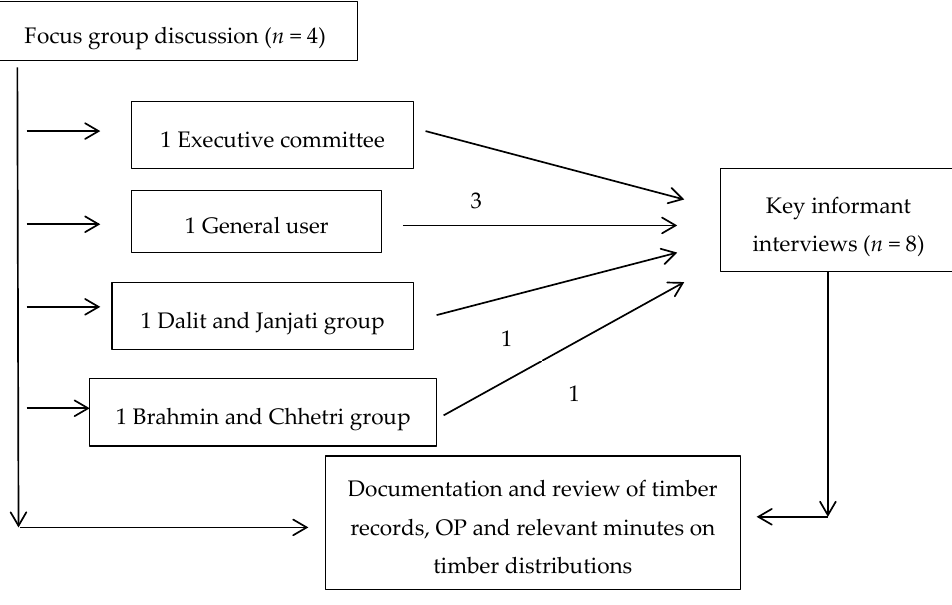
Figure 2. Data collection flow chart.